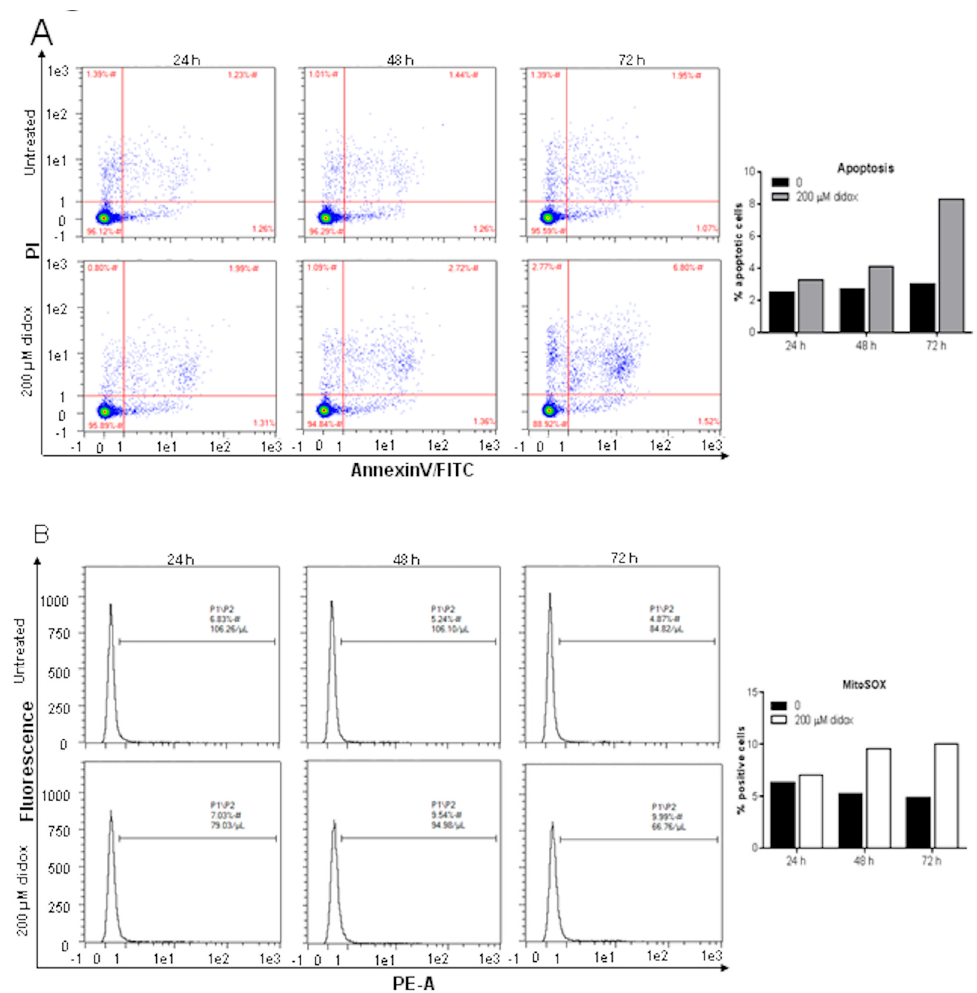
Figure 3. Didox induced apoptotic cell death and mitochondrial oxidative stress in HA22T/VGH cell lines. Cells were untreated or treated with 200 µM of didox for 24, 48 and 72 h. At each time point, cells were analyzed for apoptotic cell death combining AnnexinV/FITC/PI ( A ) or using MitoSOX Red mitochondrial superoxide indicator ( B ) and analyzed by flow-cytometry. The histograms show the percentage of apoptotic cell death, positive to AnnexinV ( A ) or fluorescent cells positive to MitoSOX mitochondrial superoxide indicator (PE-A,) ( B ).